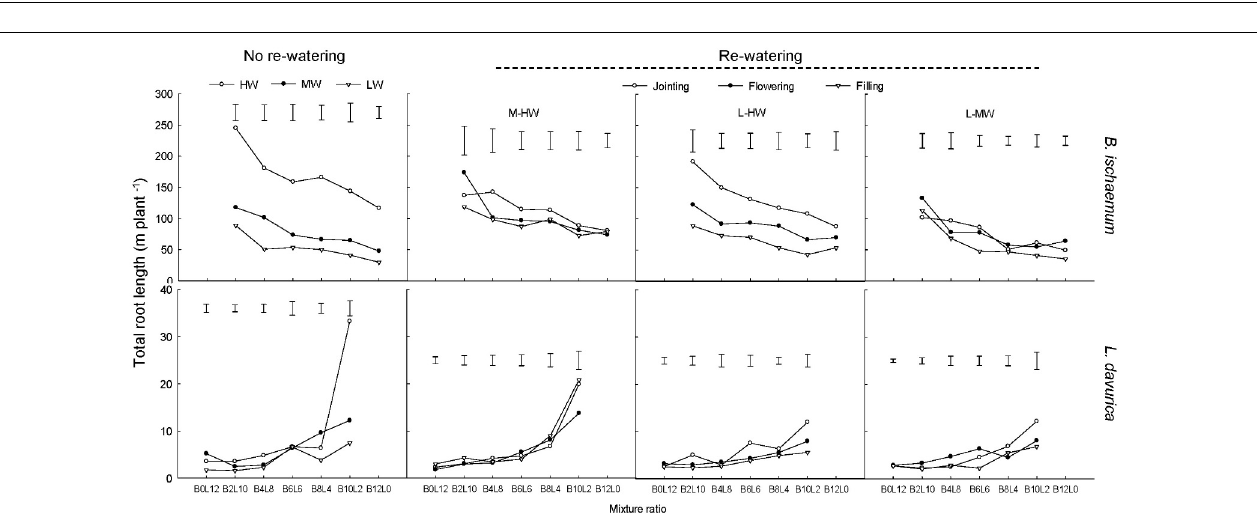
FIGURE 2 | Root average diameter (RAD) of B. ischaemum (B) and L. davurica (L) at various mixture ratios under each water treatment. HW: 80 ± 5% FC; MW: 60 ± 5% FC; LW: 40 ± 5% FC; M-HW: soil water content increased from MW to HW; L-MW: soil water content increased from LW to MW; L-HW: soil water content increased from LW to HW. The vertical bars indicate the LSD values ( P ≤ 0.05) for the RAD difference of each species among water treatments and mixture ratios under each rewatering period or constant water supply.